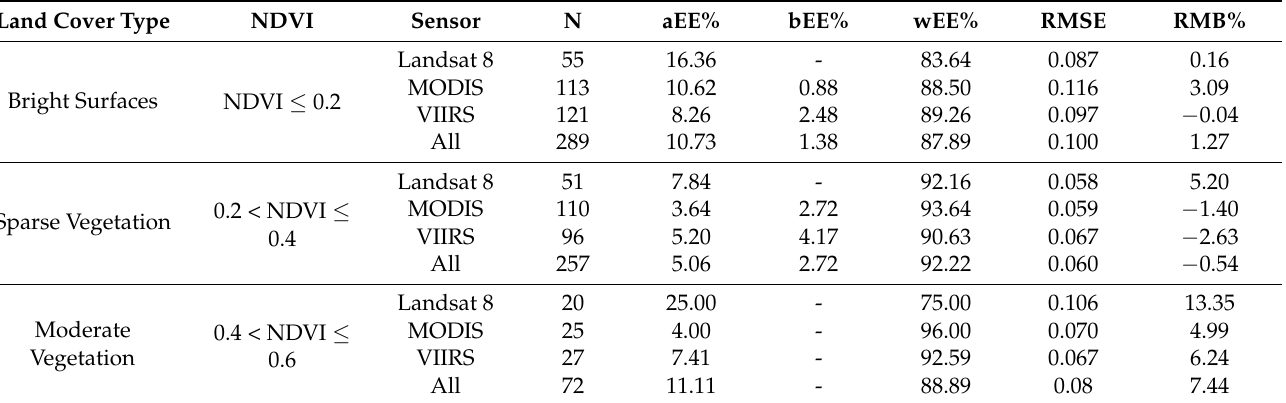
Table 3. Performance of the SEMARA Landsat , SEMARA MODIS , and SEMARA VIIRS retrieved AOD over different land surface types, stratified according to NDVI